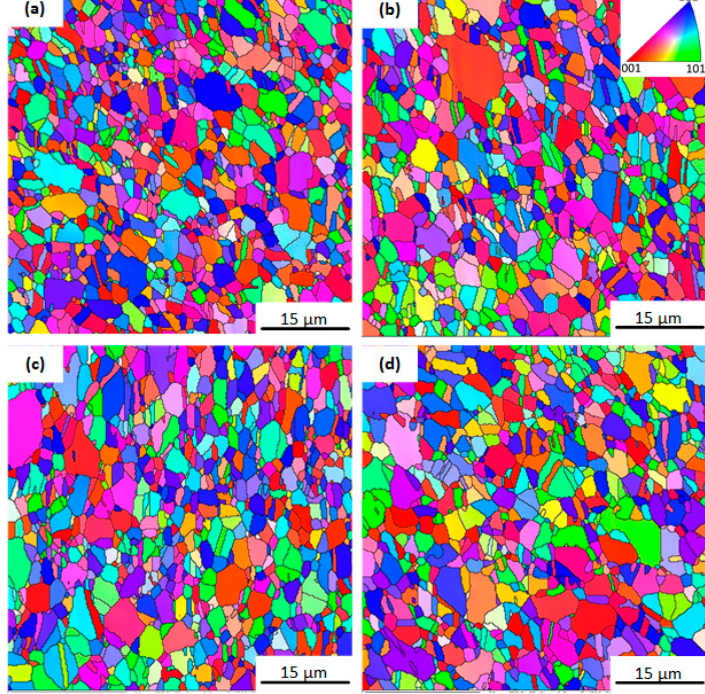
Figure 10. Inverse pole figures under different annealing times: ( a ) 10 min; ( b ) 30 min; ( c ) 120 min; and ( d ) 240 min.